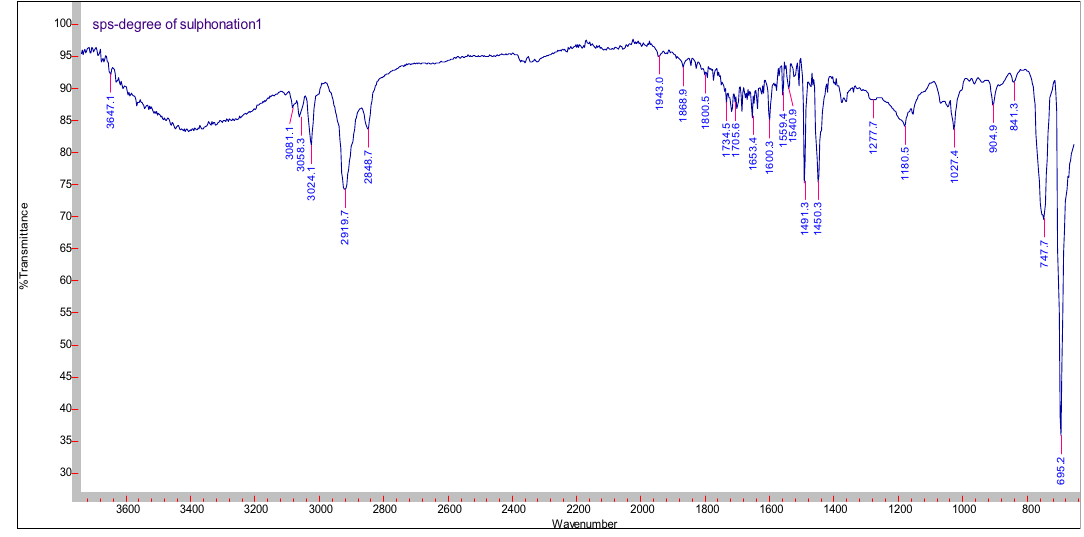
Figure 5. FTIR spectra of the sulfonated